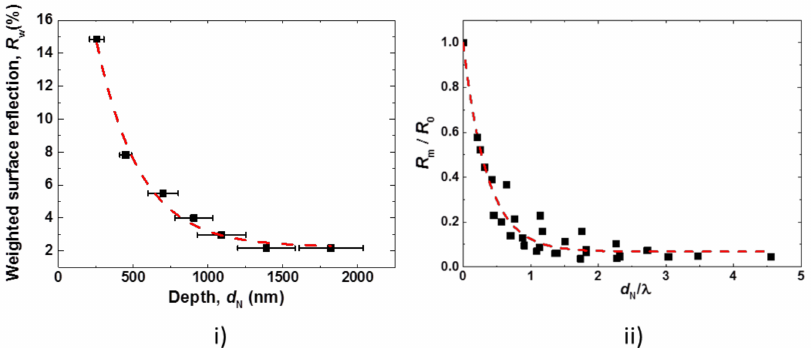
Figure 15. Plots showing ( i ) exponential reduction of normalized reflection for an increasing depth of nanostructures, and ( ii ) R m / R 0 at each value of d N / λ of nanotextured surfaces. The influence of the scattering is minimized by not considering the wavelengths lower than 400